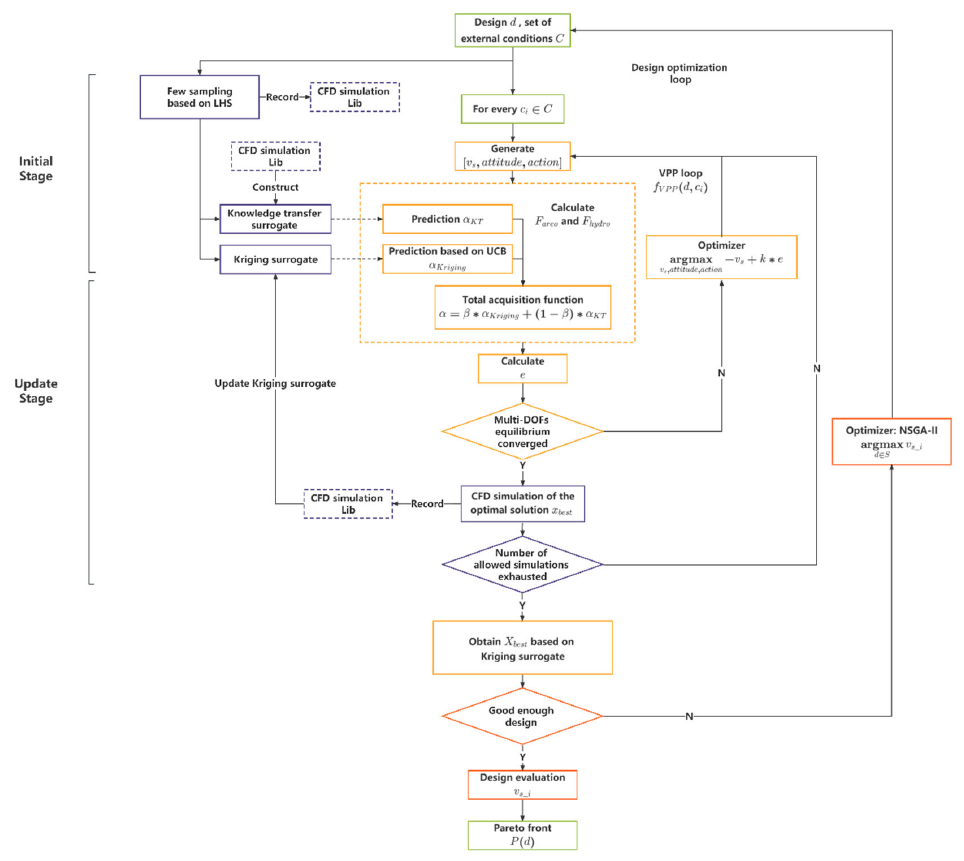
Figure 6. The flowchart of the proposed framework. Note: The same colouring scheme is used as Figure 6. The fl owchart of the proposed framework. Note: The same colouring scheme is used as in Figure 1 for comparison. in Figure 1 for